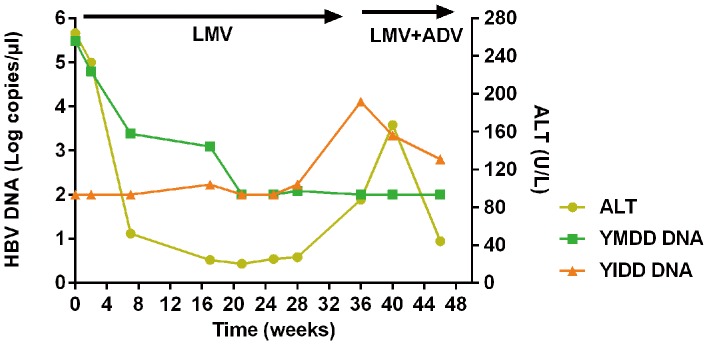
Dynamics of HBV YMDD, YIDD DNA levels and serum ALT level during LMV and LMV + ADV therapy in a CHB patient with breakthrough hepatitis.